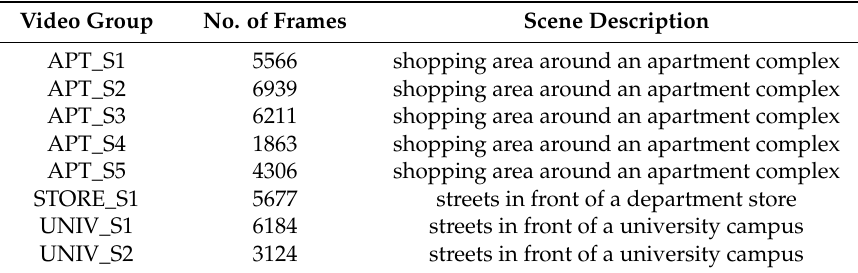
Table 2. The test video clips